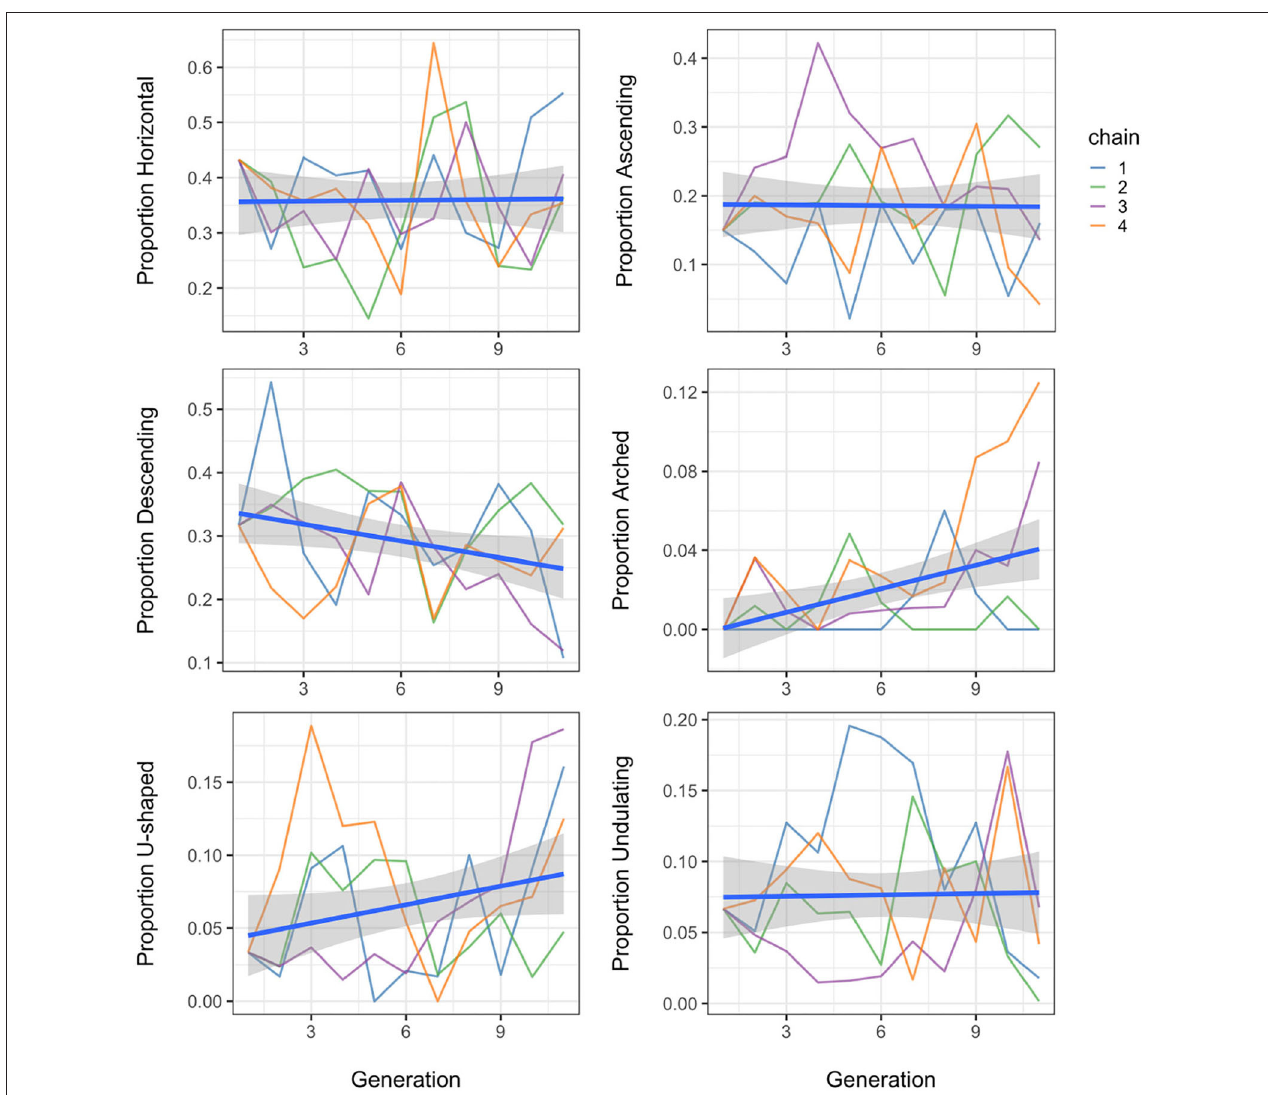
FIGURE 8 | Distribution of segment types over generations, showing the proportion of each type in the four chains, over generations. Each whistle segment has been categorised as horizontal if there are no ascending or descending slides, ascending if it has ascending slides only, descending if it has descending slides only, arched for first ascending, then descending, u-shaped for first descending, then ascending and undulating in case of multiple changes of direction.